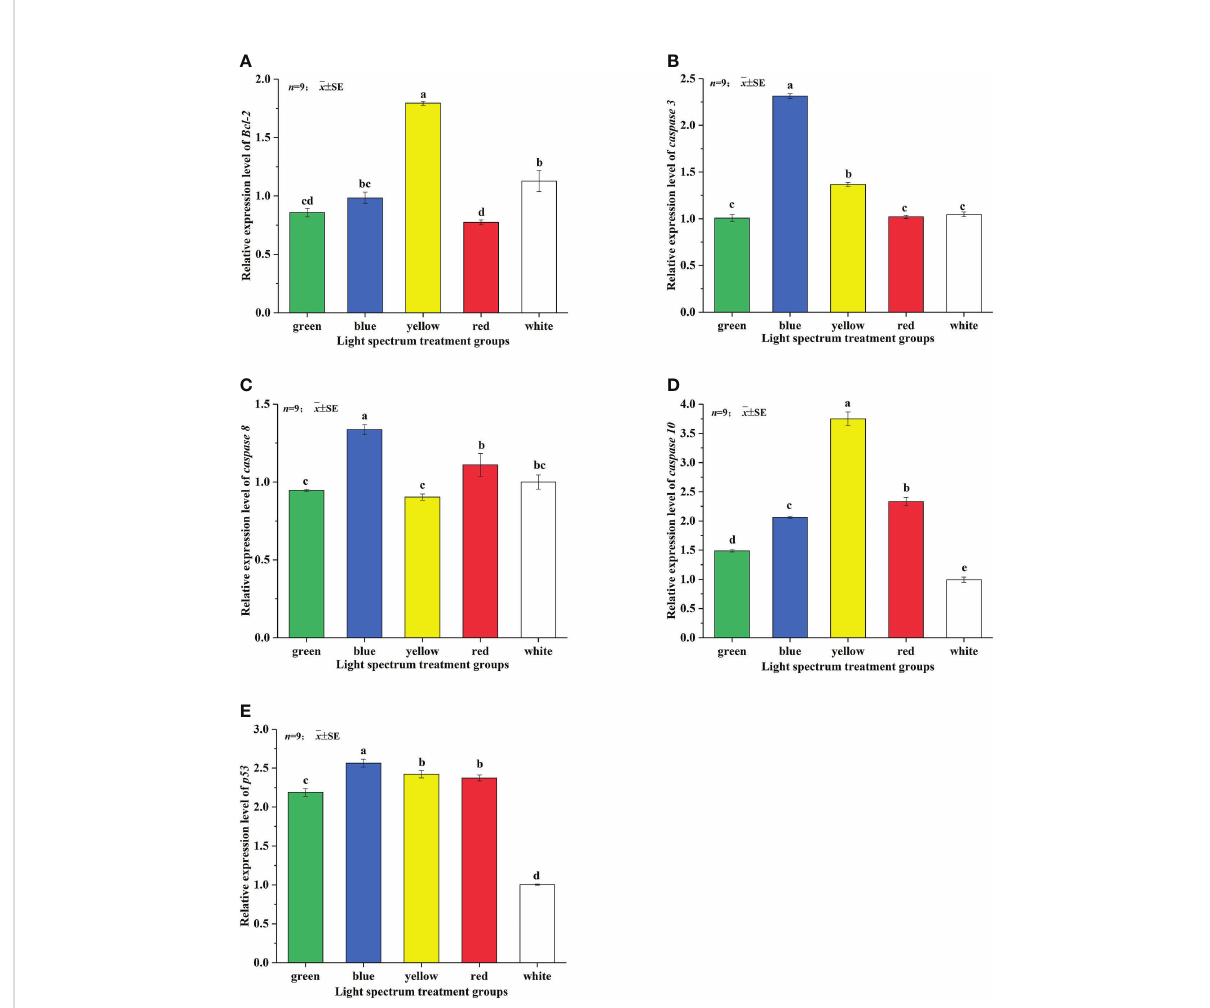
FIGURE 4 Effects of different LED spectra on the relative expression of Bcl-2 (A) , p53 (B) , caspase 3 (C) , caspase 8 (D) and caspase 10 (E) genes in juvenile Takifugu rubripes. In the same column diagram, values with same small letter superscripts mean no signi fi cant differences ( P >0.05), different small letter superscripts mean signi fi cant differences ( P